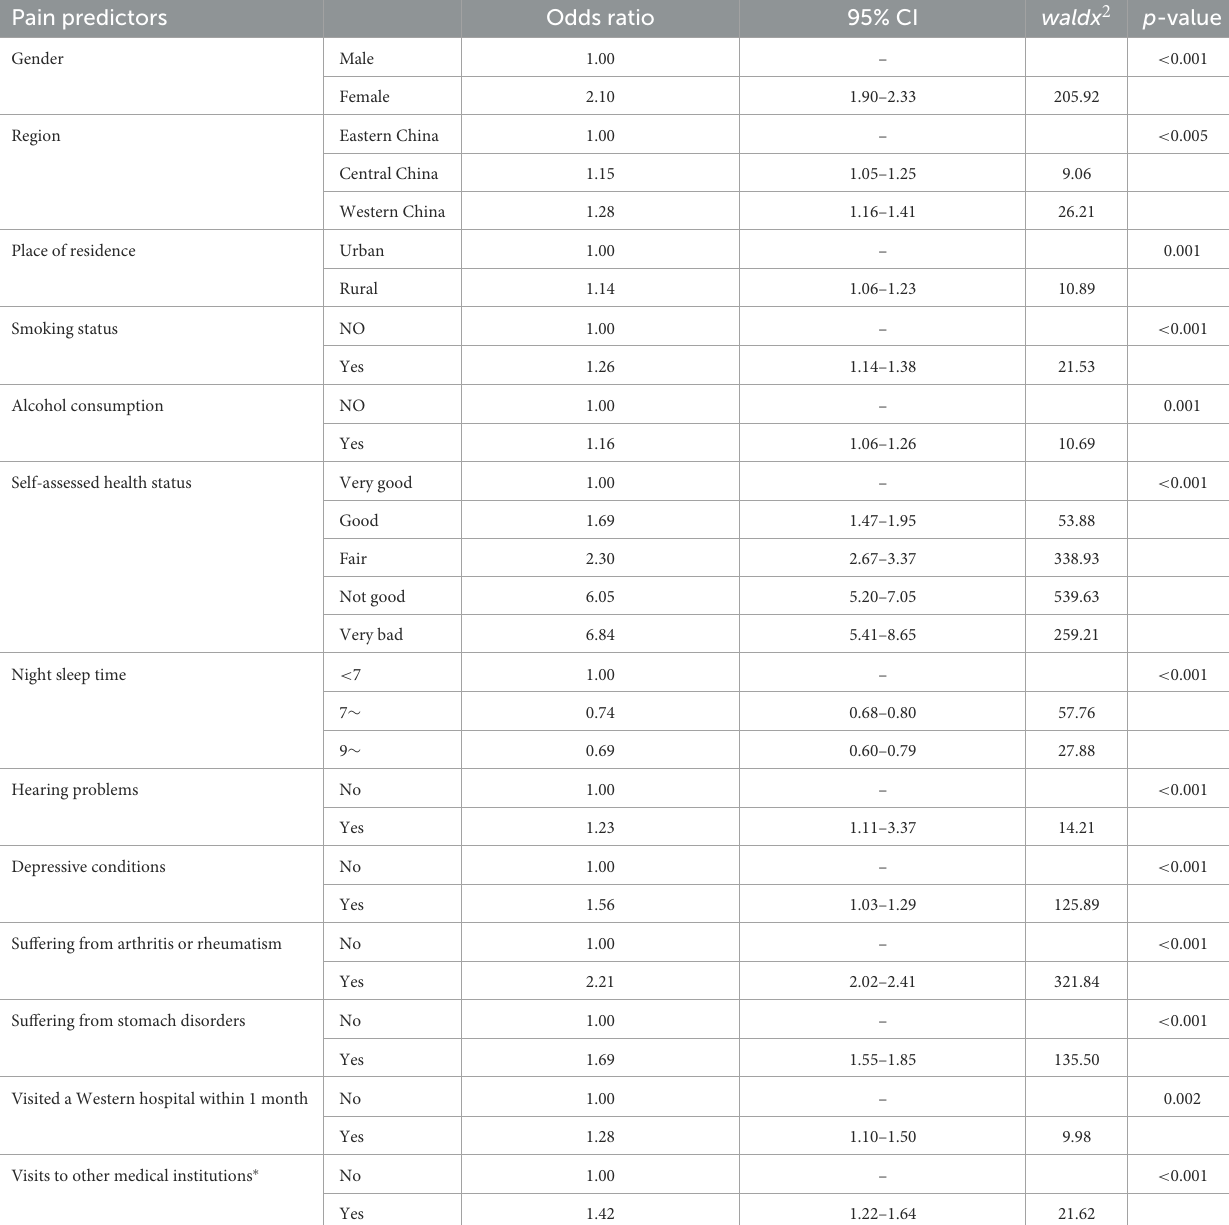
TABLE 4 Logistic regression to determine statistically significant